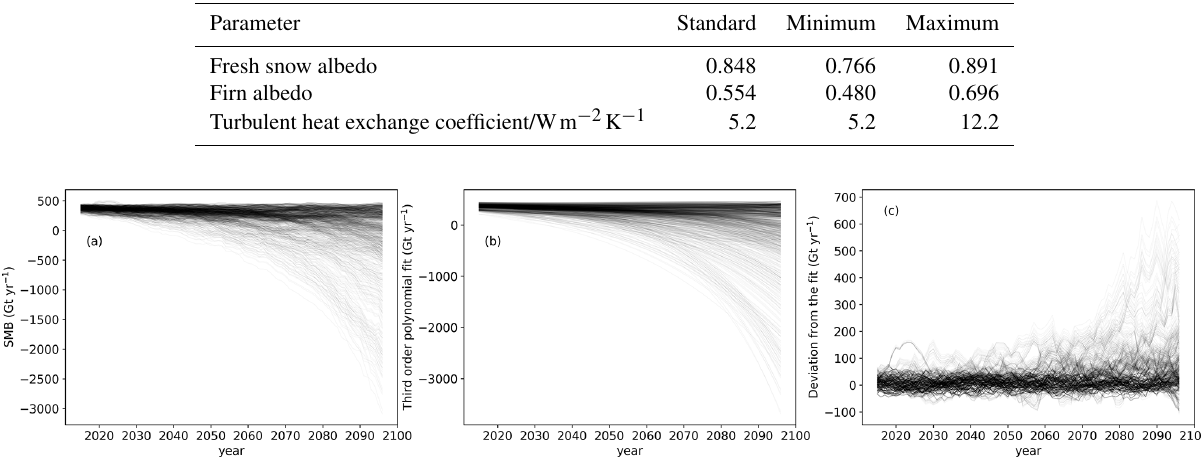
Table C1. Parameters in BESSI that are varied in this study. Standard stands for the simulations with only one parameter combination. All parameter combinations use the same albedo routine from Bougamont et al. (2005) and an ice albedo of 0.4.